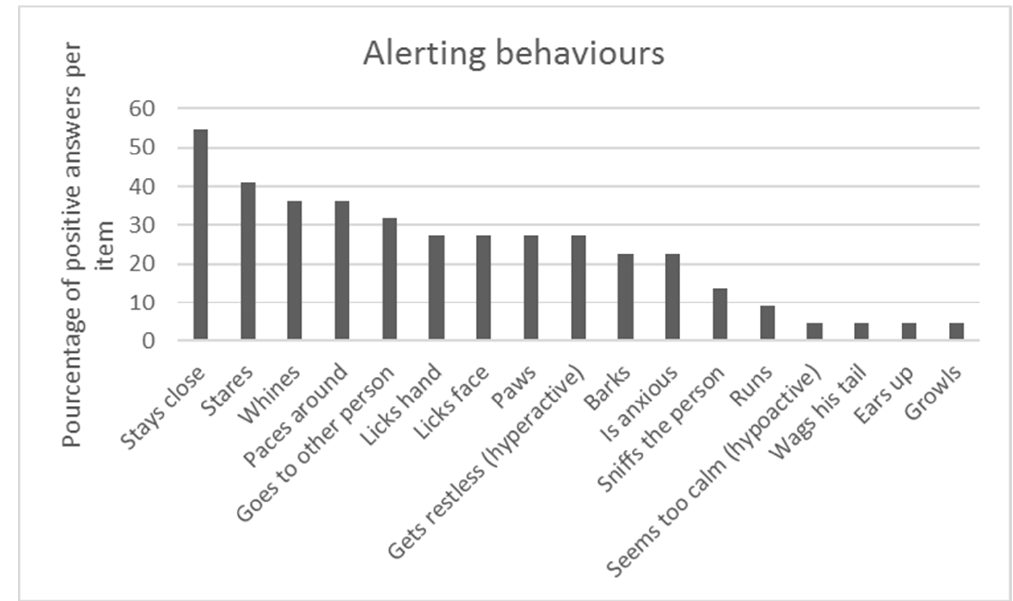
Figure 1. Dogs’ alerting behaviors (in percent).